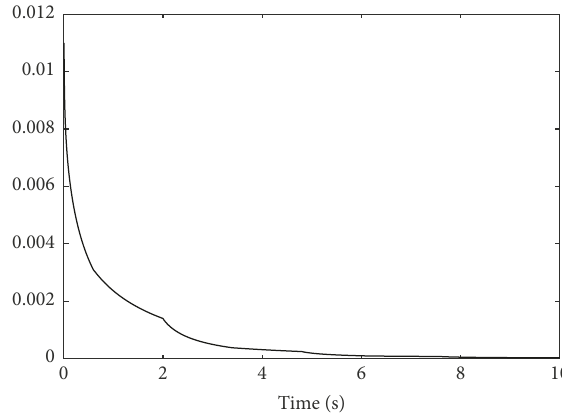
Figure 6: The evolution of 𝑥 𝑇 (𝑡)𝜀 of system